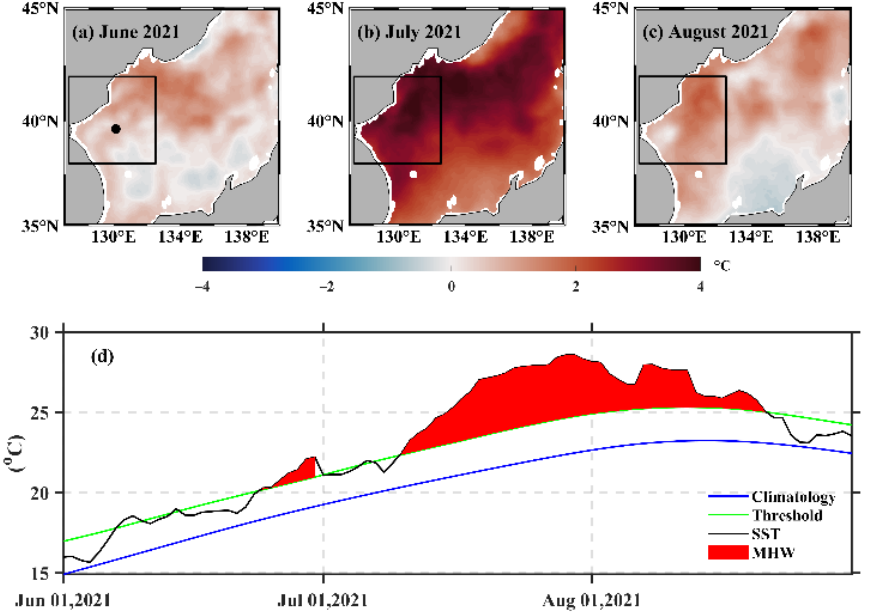
Figure 5. ( a – c ) SST anomalies from June to August 2021 (units: °C). The black box is the study area. ( d ) Event line for detected MHWs at the black dot in ( a ). The blue, green, and black curves are the climatology, the 90th percentile threshold, and SST, respectively. The red-shaded regions indicate MHW events.